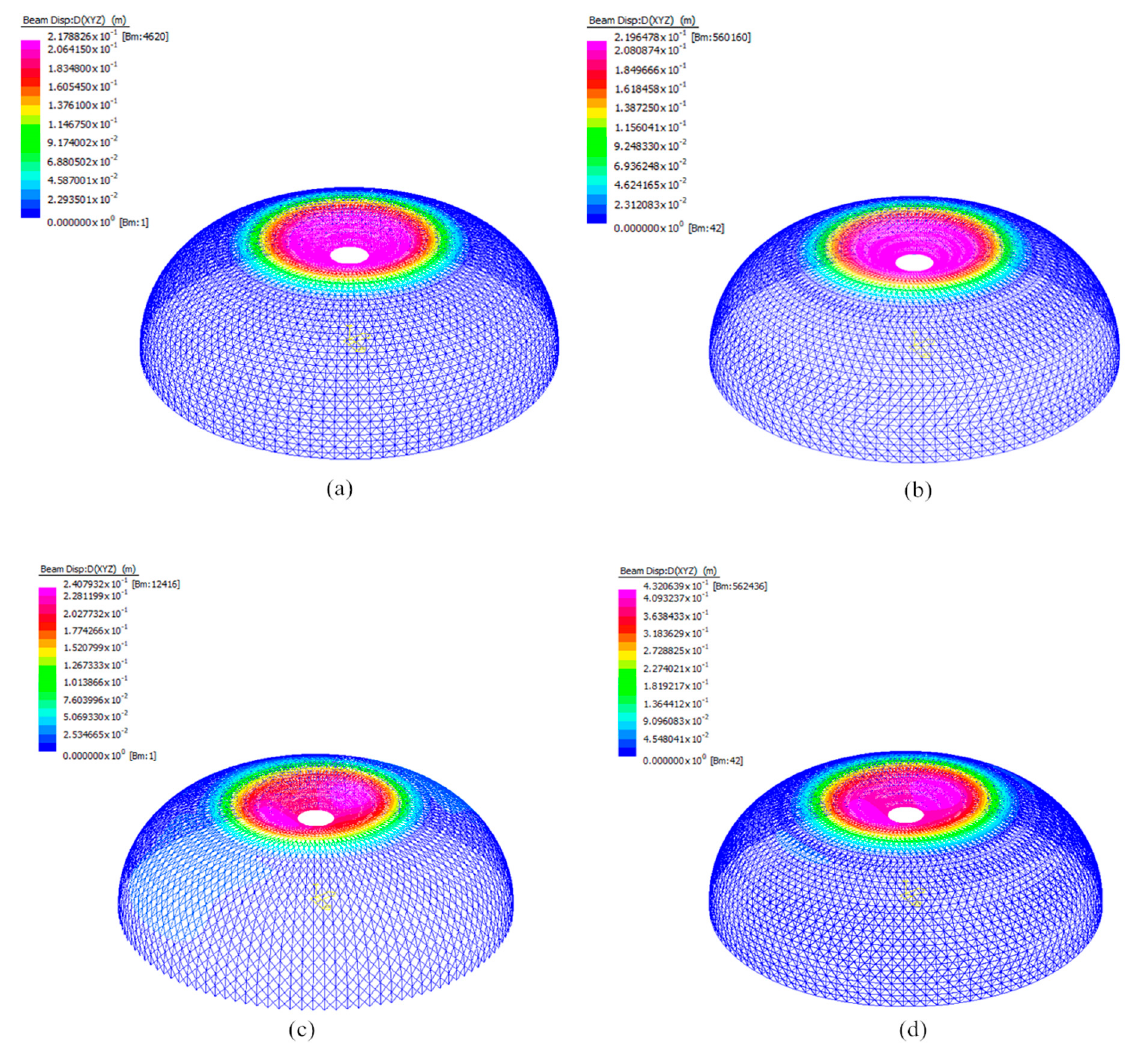
Figure 16. ( a ) Total beam displacement in the straight member model by nonlinear static analysis (G + 0.7Q); ( b ) total beam displacement in the curved member model by nonlinear static analysis (G + 0.7Q); ( c ) total beam displacement in the straight member model by nonlinear static analysis (G + 0.7Q + W); ( d ) total beam displacement in the curved member model by nonlinear static analysis (G + 0.7Q + W).